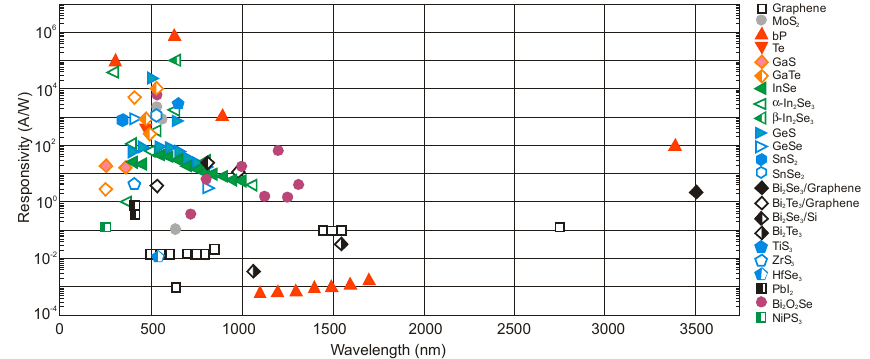
Figure 4. Summary of spectral responsivities to the layered 2D materials (after